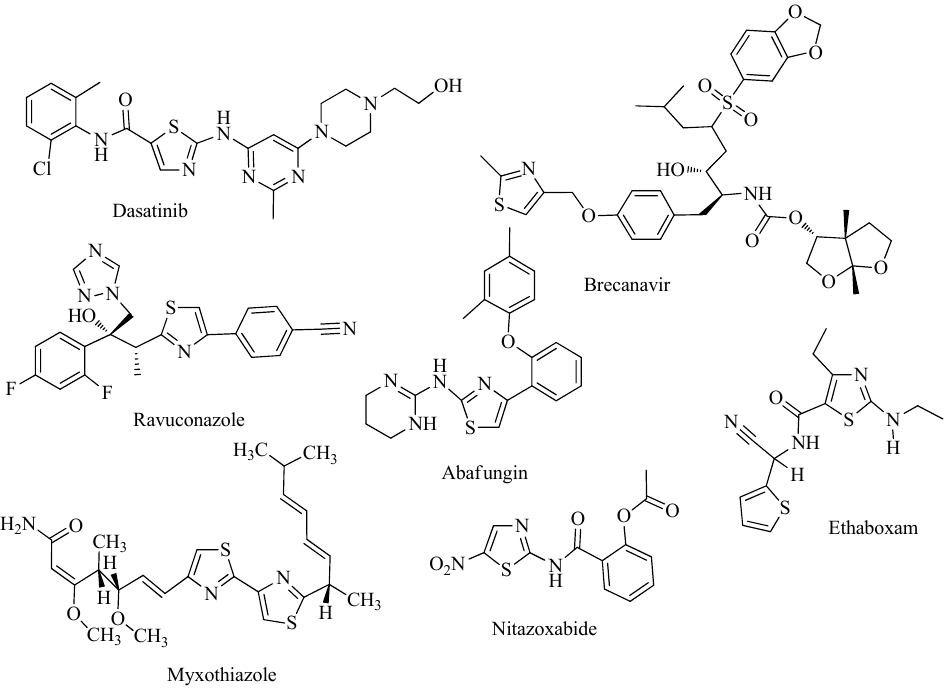
Figure 1. Thiazole-based approved drugs.